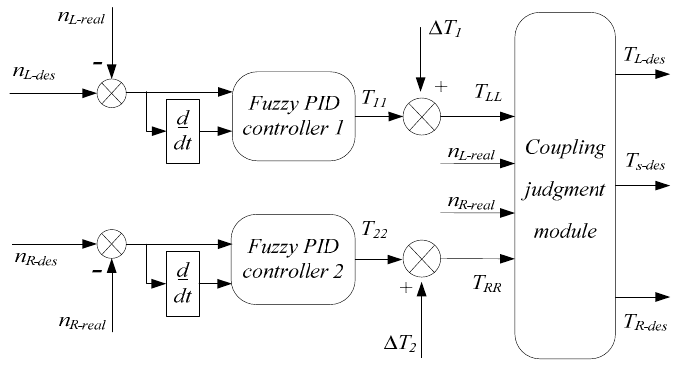
Figure 7. Coupling distribution controller.